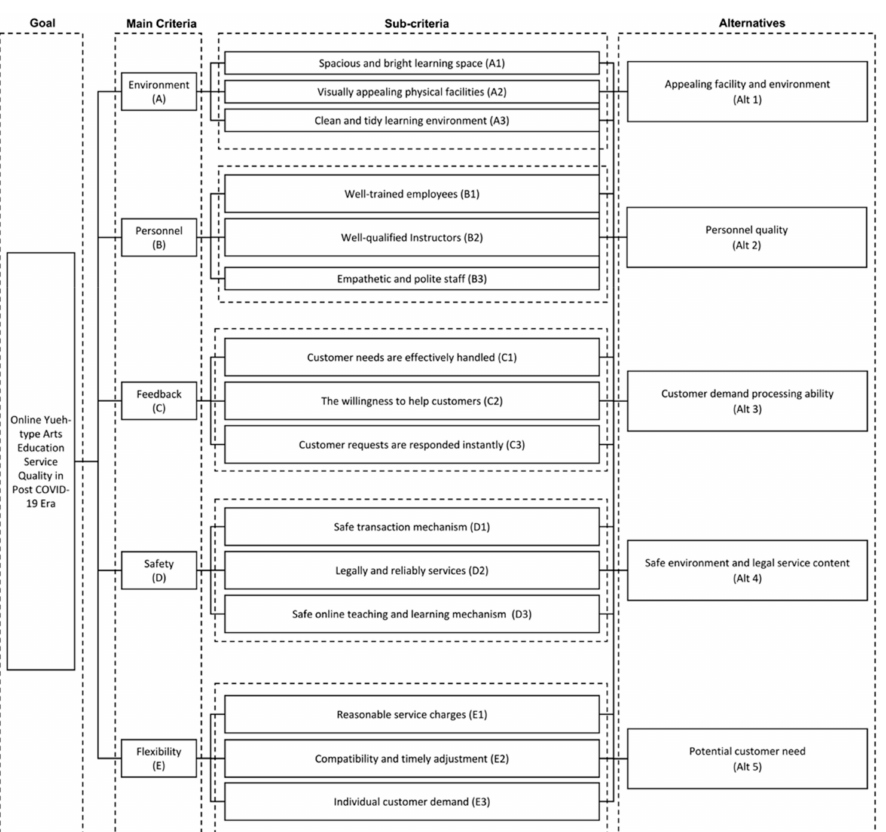
Figure 2. Evaluation criteria